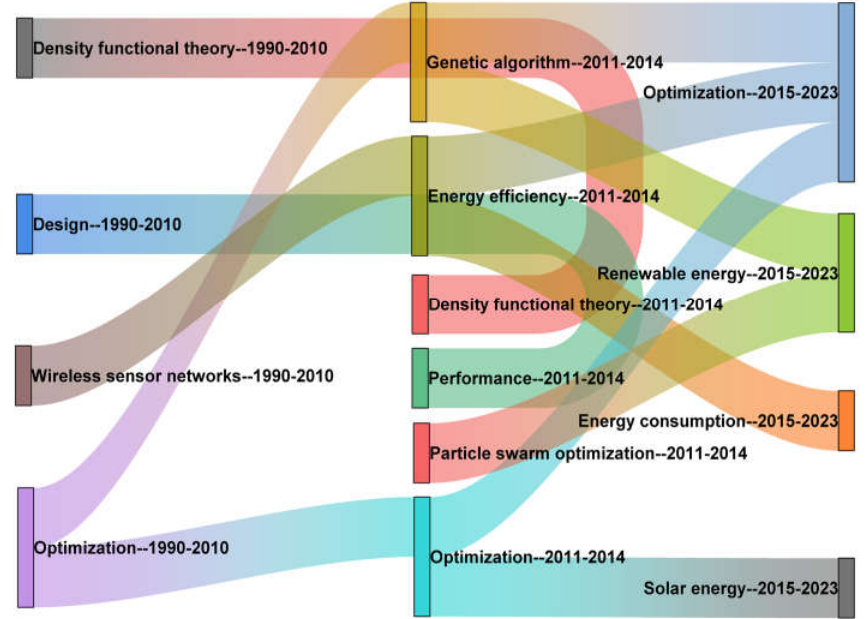
Figure 14. Thematic evolution.